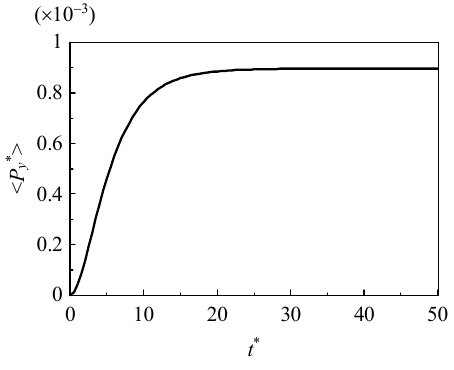
Fig.4 Transient behavior of flexoelectric polarization along y -direction for Er=500 and